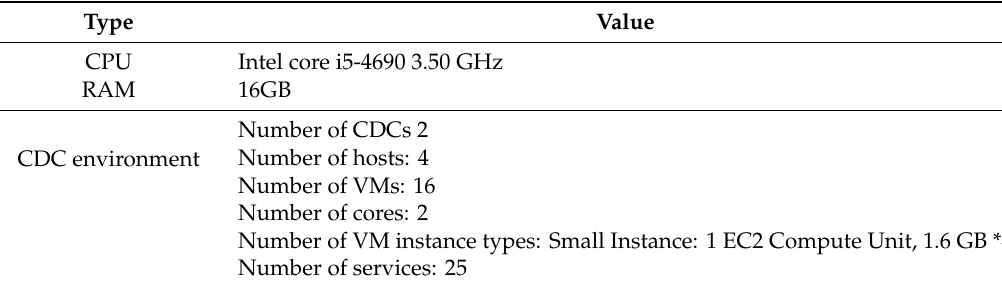
Table 9. Evaluation environment.